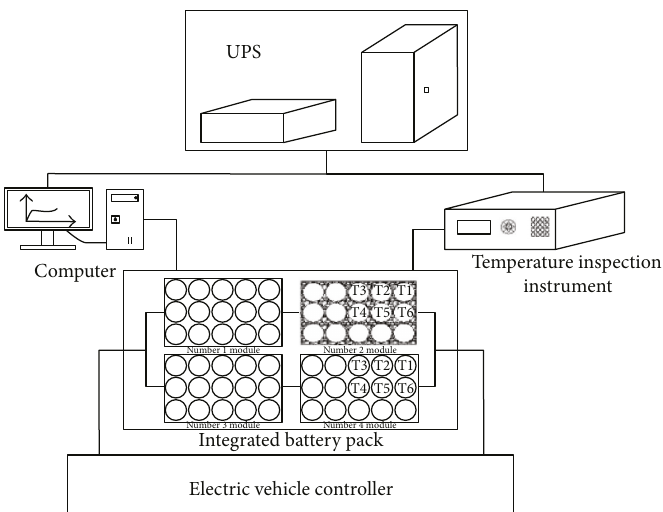
Figure 4: An illustration of the loading test setup.